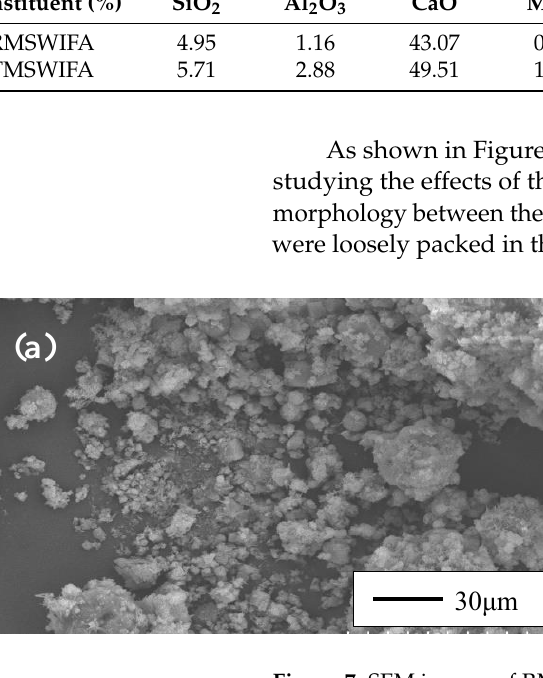
Table 4. Composition comparison of raw MSWI fly ash and treated MSWI fly ash.